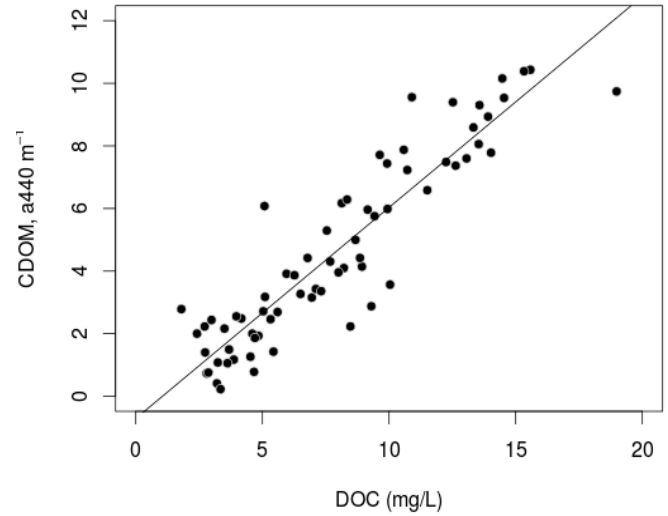
Figure 3. Relationship between DOC and CDOM in the Yenisei River (DOC = 2.13 + 1.24 × (CDOM), R 2 = 0.84, p -value < 0.001). 69 field observations were used from February 2014–September 2014 and